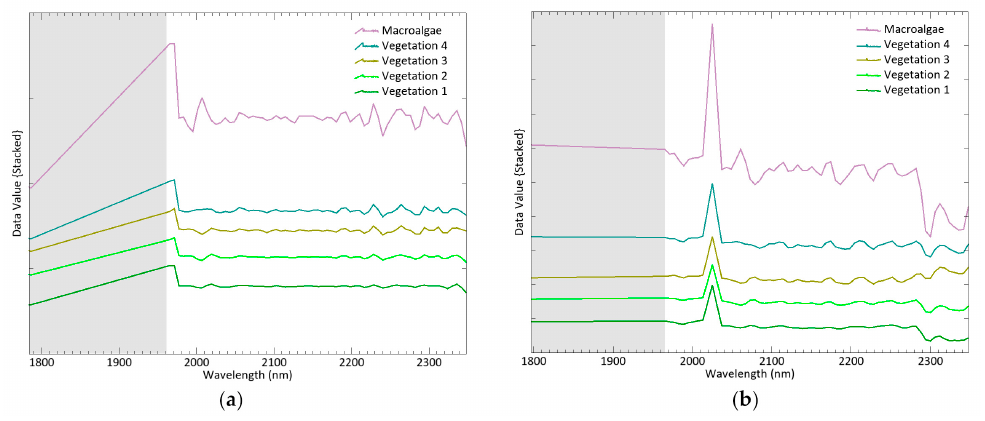
Figure A4. The focus is on the SWIR2 region of the electromagnetic spectrum. The main peaks can be identified in the 2nd derivative spectrum of the five studied spectral signatures ( a ). The boxcar average smoothing filter applied on the 2nd derivative spectrum highlights other important peaks for the studied signatures ( b ). The SWIR2 region presents absorbance peaks at 1971, 2007, 2025, 2054, 2114, 2192, 2228, 2264, 2293, and 2335 nm. In grey is one of the water vapour absorbance regions (1790–1960 nm) excluded from the hyperspectral processing.